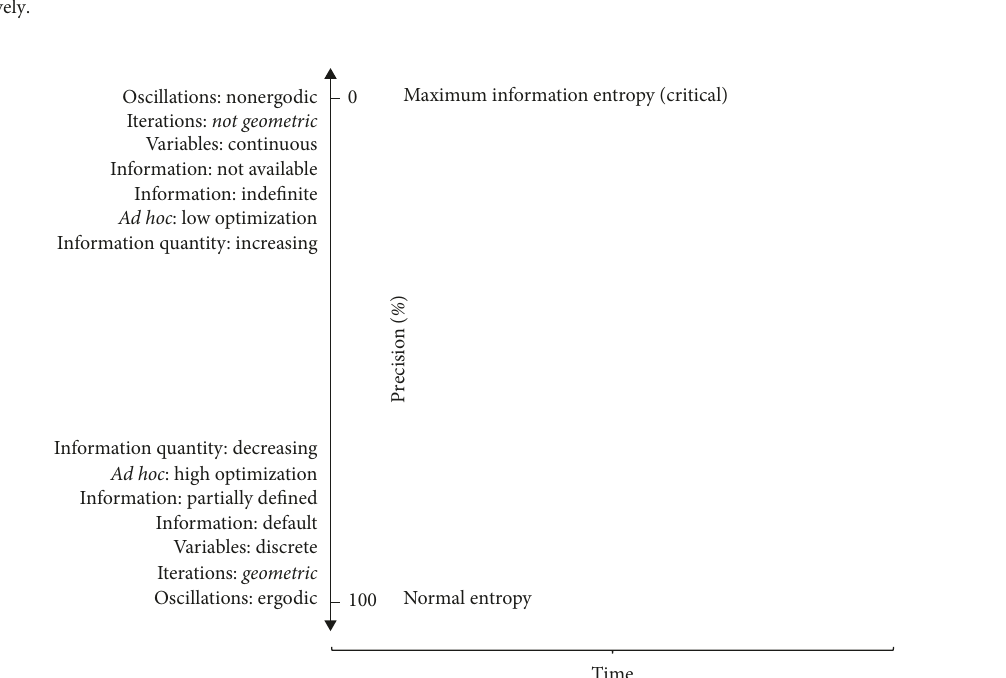
Figure 9: Representative diagram of precision variations in the flow of information and the mathematical, physical, and biological properties. The diagram helps to understand the variables that accompany the addition or reduction of precision in complex adaptive systems in